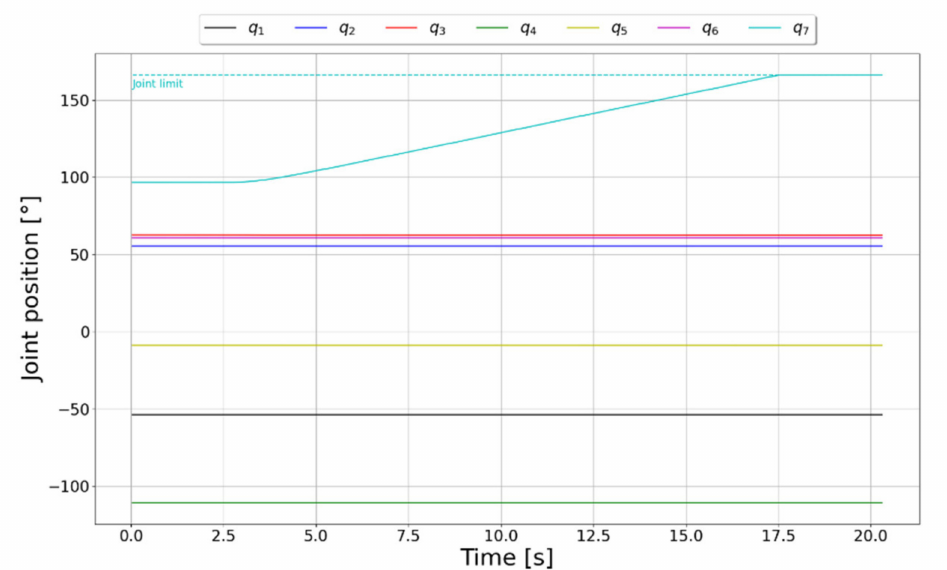
Figure 18. Joint position trajectories in the absence of a JLA strategy.